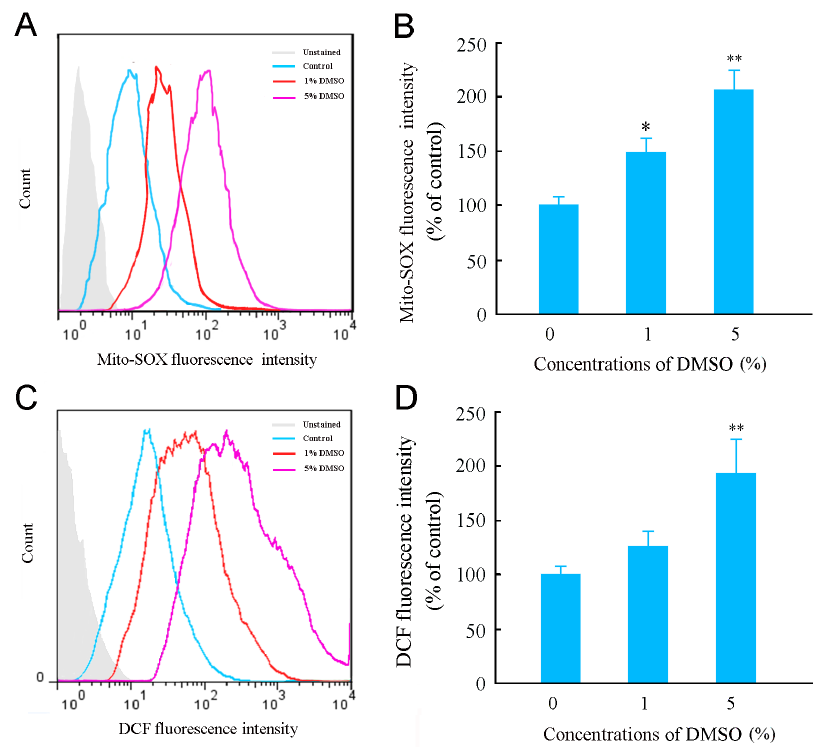
Figure 5. Effects of DMSO on mitochondrial and intracellular ROS generation in cultured mouse cortical astrocytes. ( A ) Representative flow cytometry data showing Mito-SOX fluorescence, a highly selective indicator of superoxide in live cell mitochondria, in astrocytes treated with various concentrations of DMSO for 24 h. ( B ) Quantitative analysis revealed that the Mito-SOX fluorescence intensity increased in astrocytes treated with DMSO with a dose-dependent manner. ( C ) Representative flow cytometry data showing DCF fluorescence in astrocytes treated with various concentrations of DMSO for 24 h. ( D ) The quantitative analysis showed that ROS levels were increased in astrocytes treated with DMSO at 5% concentration but not at 1%, by detecting the fluorescence intensity of DCF. ( E ) Data are shown as a mean 6 SEM of five independent experiments performed in triplicate. * P , 0.05, ** P , 0.01 versus control group. # P , 0.05, ## P , 0.01 versus 5% DMSO treated group.